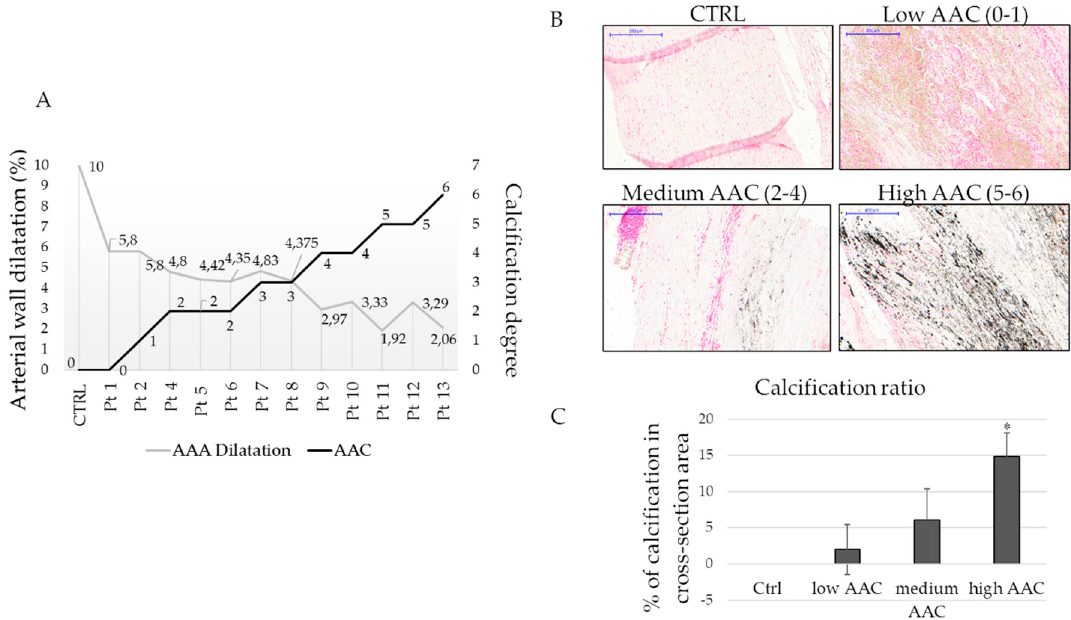
Figure 1. Wall stress and calcification correlation. ( A ) Graph showing the relation between abdominal aortic aneurysm (AAA) dilatation and calcification (AAC, aortic aneurysm calcification); ( B ) Representative images of calcification degree evaluated by Von Kossa staining in paraffin-embedded tissues, scale bar 200 µm; ( C ) Quantification of calcium content in healthy tissues (CTRL) and aneurysm tissues evaluated by ImageJ software. * indicates p ≤ 0.05 respect to control.